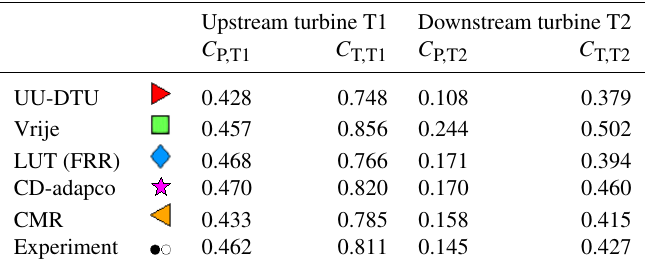
Figure 5. Power coefficient C P (a) and thrust coefficient C T (b) for T1 (filled circles) and T2 (empty circles) compared for test case A. The downstream turbine T2 is positioned at x/D = 5.18 downstream of T1, and the upstream turbine T1 is operated at λ T1 = 6.0. The reference velocity is U ref = 11.5ms − 1 . Table 3. Numerical values of power coefficient C P and thrust coefficient C T for test case A. The downstream turbine T2 is positioned at 5.18 D downstream of T1. T1 is operated at λ T1 = 6.0 and T2 is operated at λ T1 = 4.5, referring to the far upstream reference velocity U ref = 11.5ms − 1 . Upstream turbine